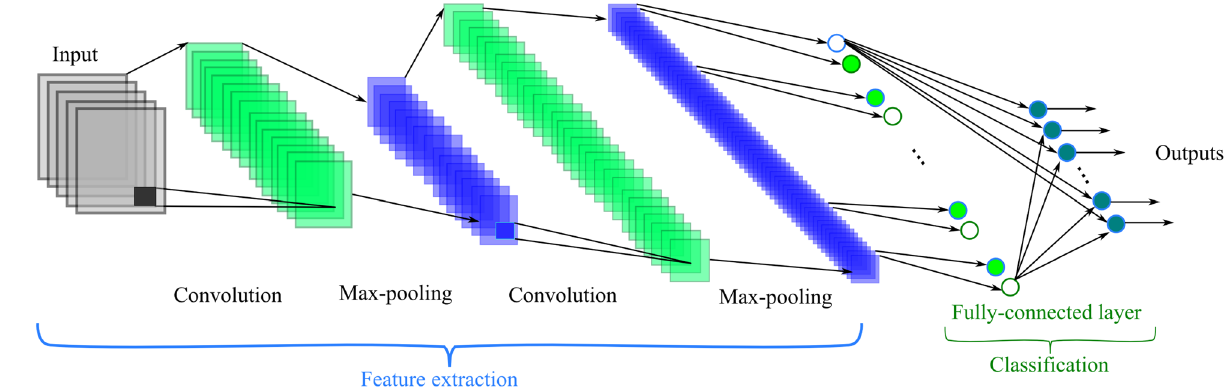
Figure 1. A CNN schematic.